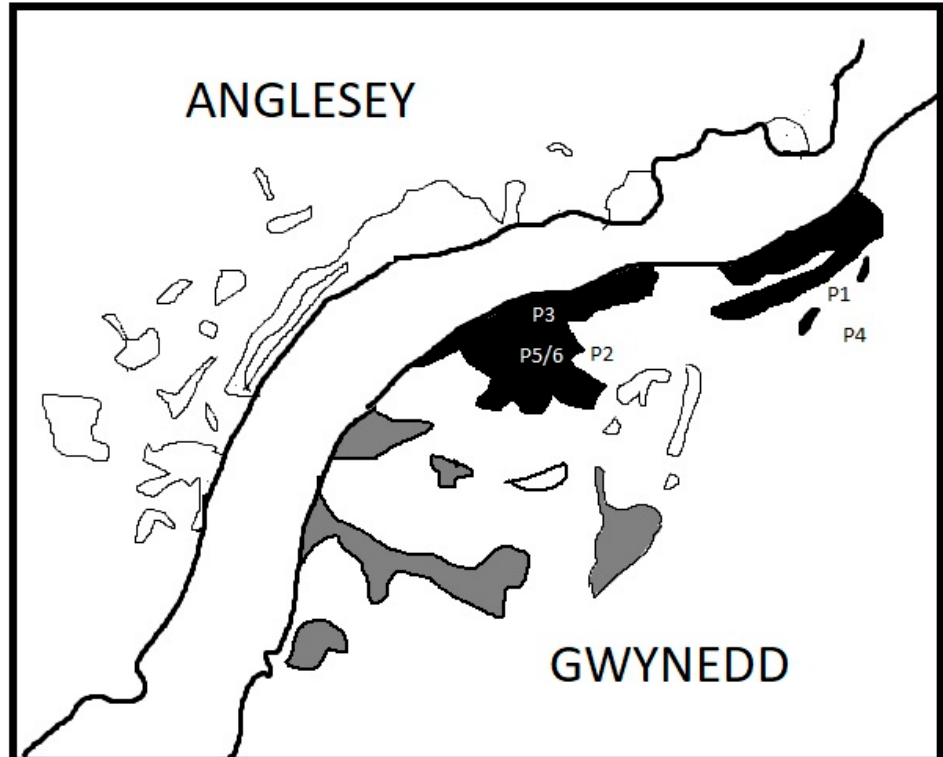
Figure 2. Locations of woodlands, in the mainland study area, not trapped (outlined); trapped with all year access (black shade) and with restricted access (grey shade). Confirmed squirrelpox case locations are shown P1 (7 September 2017), P2 (27 September 2017), P3 (22 November 2017), P4 (29